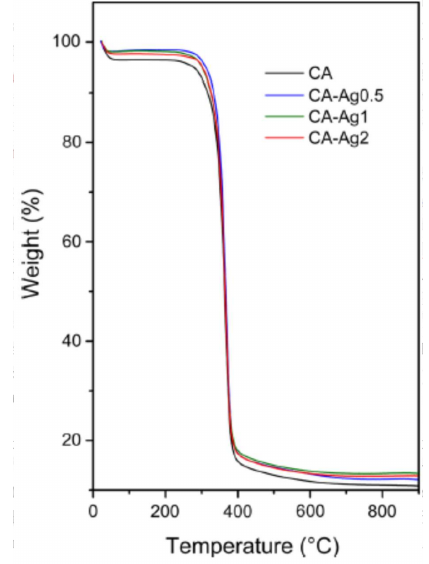
Figure 9. Thermogravimetric curves for pure CA and AgNP- β -CD membranes, taken from Andrade et al. [107].